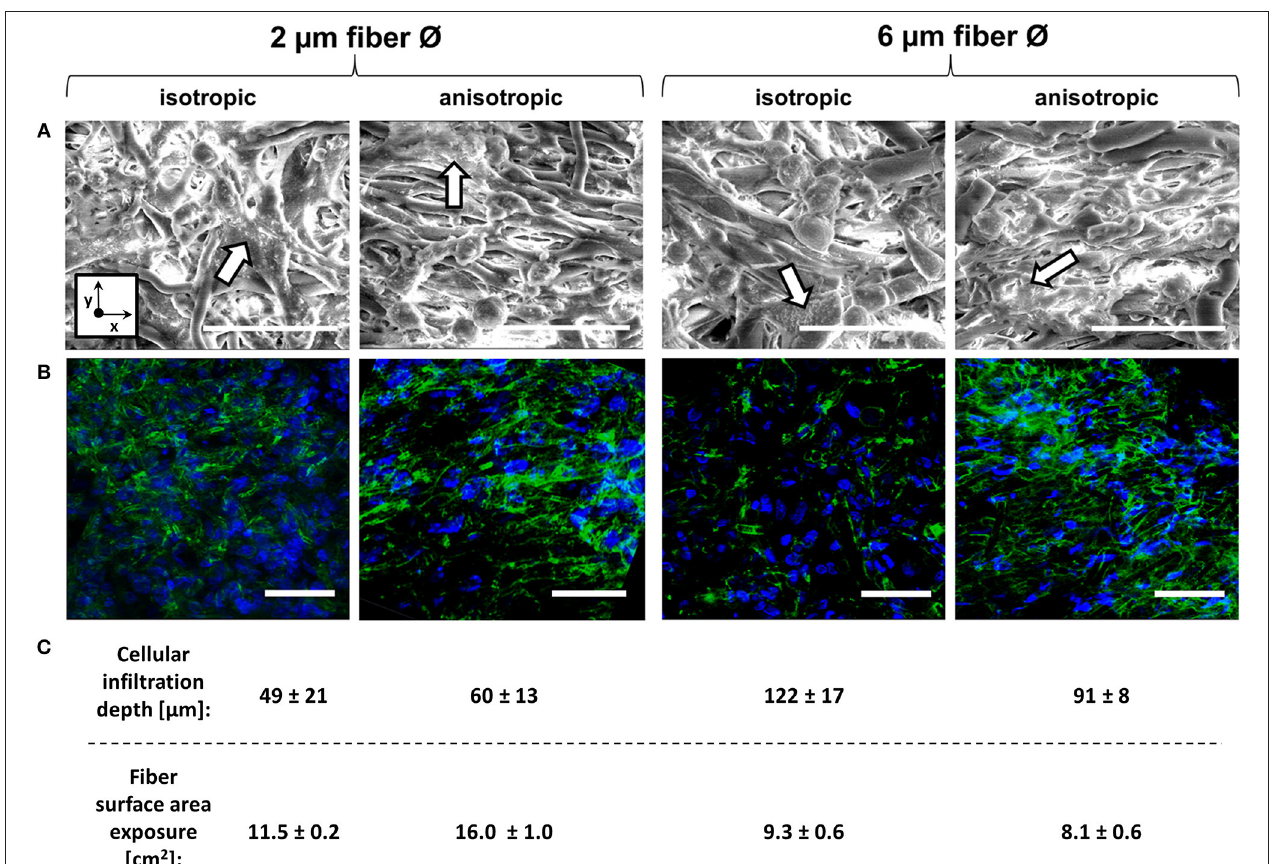
FIGURE 3 | Macrophage morphology on different scaffold microarchitectures. Representative SEM images of macrophages cultured for 8 days on the different scaffold microarchitectures. Arrows identify areas of cell clustering. (x = circumferential direction of the electrospinning mandrel; y = axial direction of the electrospinning mandrel) Scale bars, 30 µ m (A) . Representative confocal images showing the actin cytoskeleton of macrophages cultured up to 8 days on the different scaffold microarchitectures (actin in green; cell nuclei in blue). Scale bars, 50 µ m (B) . The average cellular infiltration depth ( µ m) and calculated fiber surface exposure (cm 2 ) per scaffold type (C)